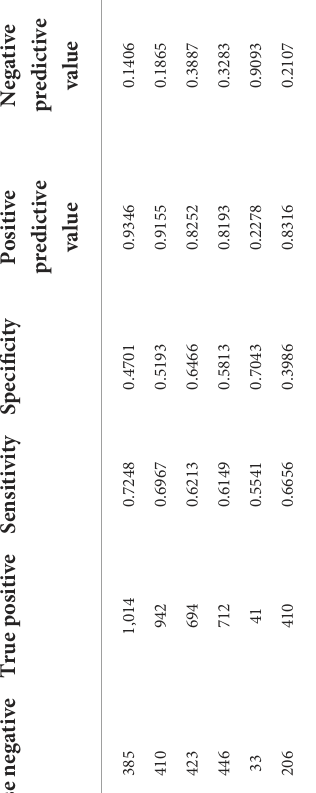
Abstinence period, the second most important factor as revealed by XGBoost, was significantly associated with semen volume in the logistic regression analysis (Supplementary Table 4). Besides, as shown in Figure 3D, the OR per the regression analysis indicated that men who smoked more than 20 cigarettes/day were more likely to have a lower semen volume (OR: 4.69, 95%